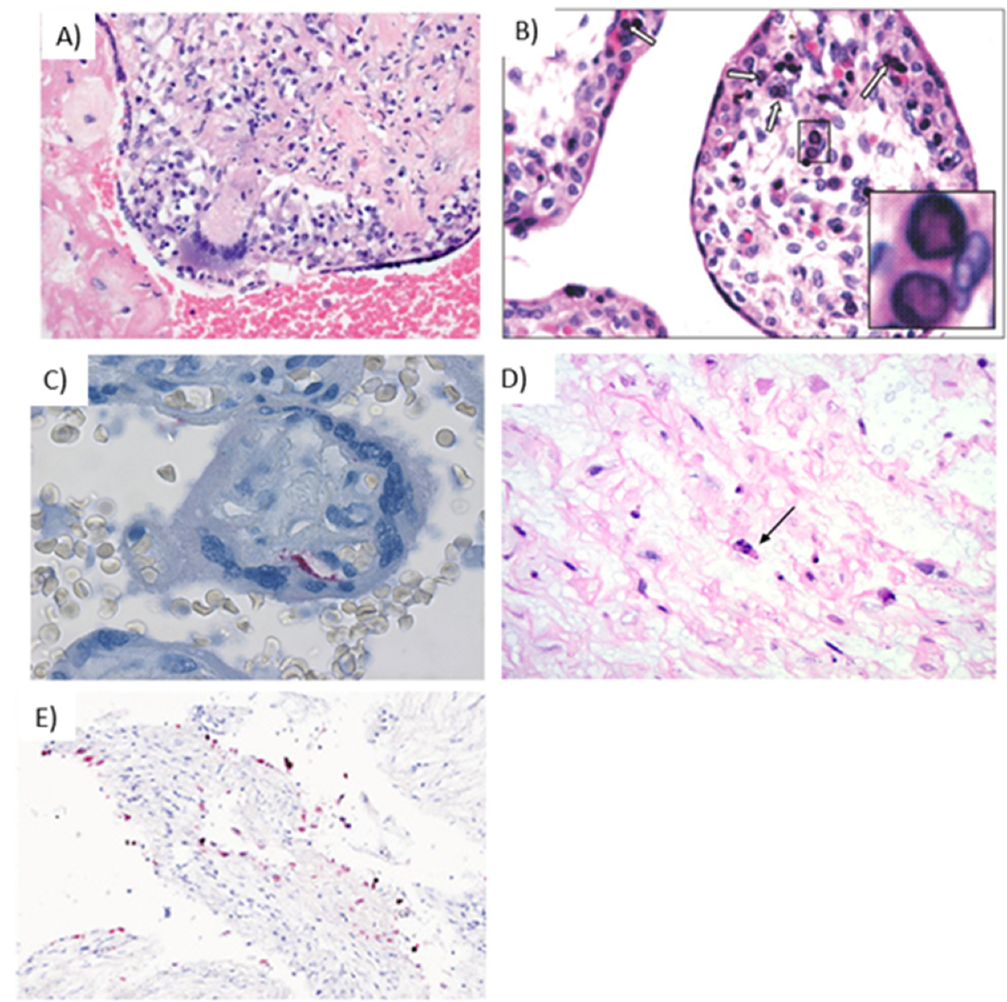
Figure 5. Hallmarks of viral infections in placental tissue. ( A ) Giant cell inflammation caused by varicella infection [142] Reprinted from “Placental and Gestational Pathology” published by Cambridge University Press; reproduced with permission of the Licensor through PLSclear (ref. 47403) ( B ) Parvovirus B19 infection in the trophoblast cells, with intranuclear inclusions (white arrows) in the capillary cells of the chorionic villi, further shown at 40× in the inset [143]. Reprinted from Quemelo et al , 2007; used with permission from SciElo Brazil under the Creative Commons License (CC BY-NC 4.0). ( C ) Rubella infection in the placenta, demonstrated by immunostaining of endothelial cells [126]. Reprinted from Lazer et al , 2016; used with permission from Elsevier (ref. 5010950239116) ( D ) Ascending HSV infection shows infected cells in the cord stroma with nuclear irregularity, hyperchromasia, and individual cell necrosis (arrow) [69]. Reprinted from Heerema-McKenny, 2018; used with permission from John Wiley & Sons, Inc. (ref. 5010940997488) ( E ) Presence of SARS-COV-2 in decidual cells (red) by in situ hybridization (200×)[144]. Reprinted from Menter et al , 2021; used with permission from S. Karger AG.